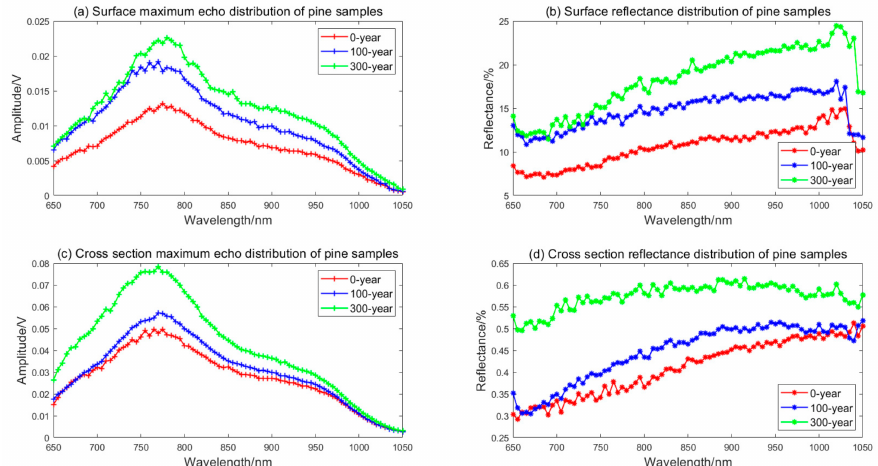
Figure 6. The comparison of pine samples surface and cross-section echo and reflectance. ( a ) Surface maximum echo distribution of pine samples. ( b ) Surface reflectance distribution of pine samples. ( c ) Cross section maximum echo distribution of pine samples. ( d ) Cross section reflectance distribution of pine samples.